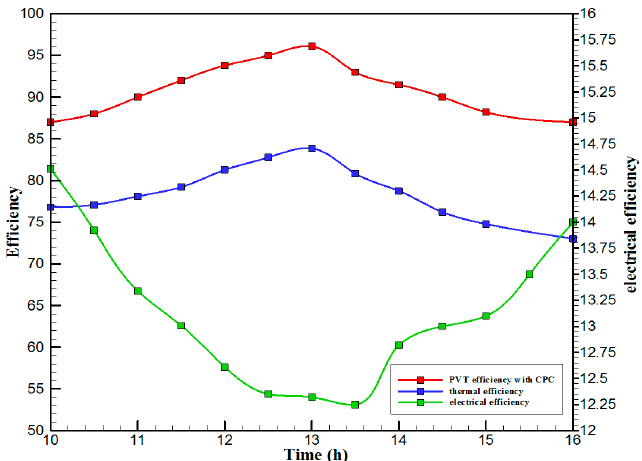
Figure 7. The hourly variation of electrical, thermal and PVT efficiency for the PVT solar collector with CPC.